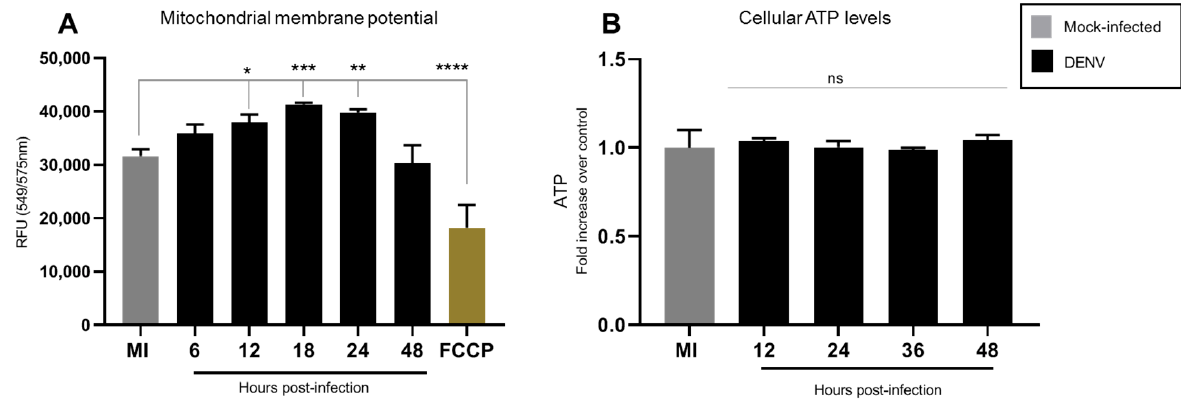
Figure 3. DENV2 infection induced a slight increase in MMP without affecting cellular ATP content. C6/36 cells were infected with DENV2 at MOI 5 and incubated for different periods of time 6, 12, 18, 24, and 48 hpi. ( A ) MMP was measured with TMRE-mitochondrial membrane potential assay at different times post-infection. Results were normalized to mock infected cells at the same time point after infection; FCCP was used as a positive control. Data represent mean ± SD of three independent experiments. Significance was determined by one-way ANOVA test followed by Dunnett ´ s multiple comparison test. p < 0.05 (*), p < 0.001(**), p < 0.0001 (***) and p < 0.00001 (****). ( B ) ATP levels were measured with the bioluminescence assay at different times post-infection. Data represent mean ± SD of three independent experiments. Significance was determined by a Kruskal–Wallis test followed by Dunn ´ s multiple comparison test. MMP: mitochondrial membrane potential; DENV: dengue virus; FCCP: Carbonyl cyanide-p-trifluoromethoxyphenylhydrazone; ns: non-significant.